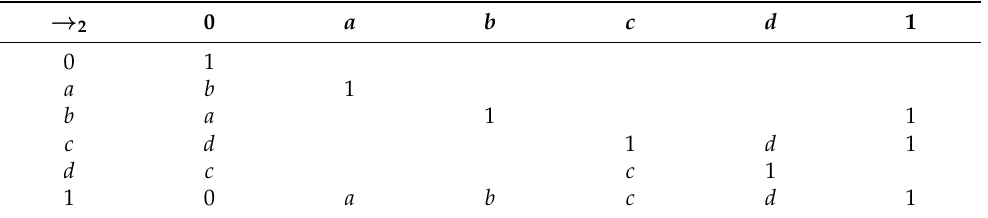
Table 11. The operation → 2